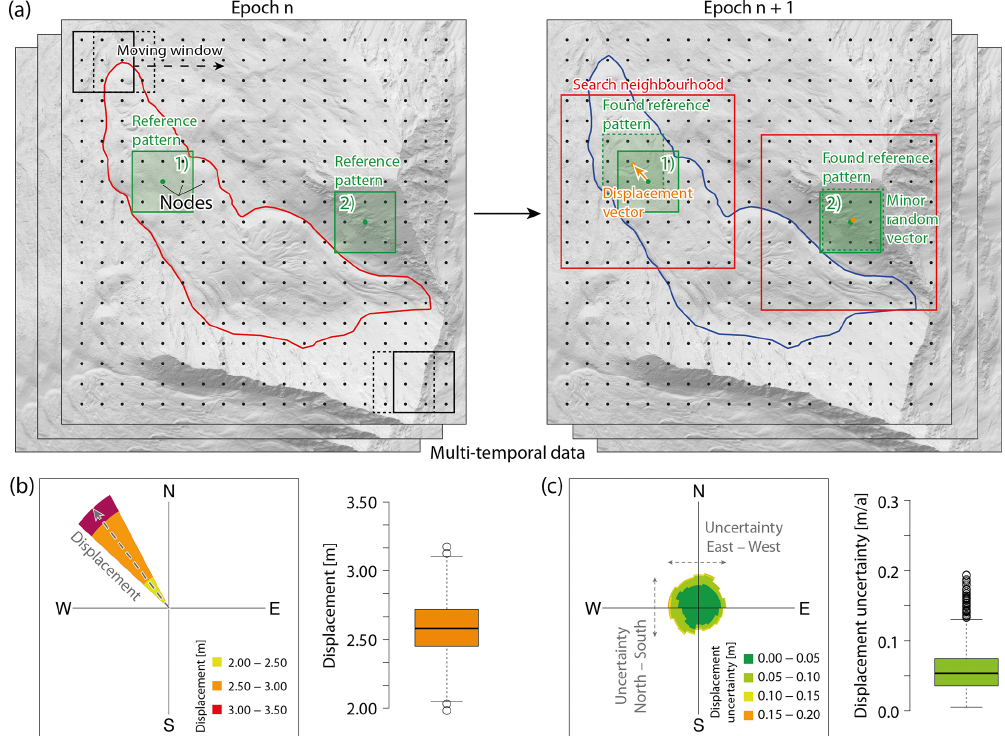
Figure 3. Concept of the applied image correlation approach. (a) In the shaded relief of the first epoch n , a box-shaped reference pattern is analysed for all regularly distributed node positions. The green boxes 1 and 2 are the reference patterns for two example nodes analysed during this process. For the second epoch n + 1, the reference pattern is matched (dashed box; significant shift for node 1, minor shift for node 2). (b) The distribution of resulting displacement vectors’ direction in epochs n and n + 1 on the rock glacier at node 1. (c) The distribution of resulting displacement vectors’ direction between epochs n and n + 1 outside of the rock glacier at node 2. The boxplots in (b) and (c) present an example of ranges of the derived vector lengths, showing that the uncertainty of the data on stable grounds is only minor compared to the resulting